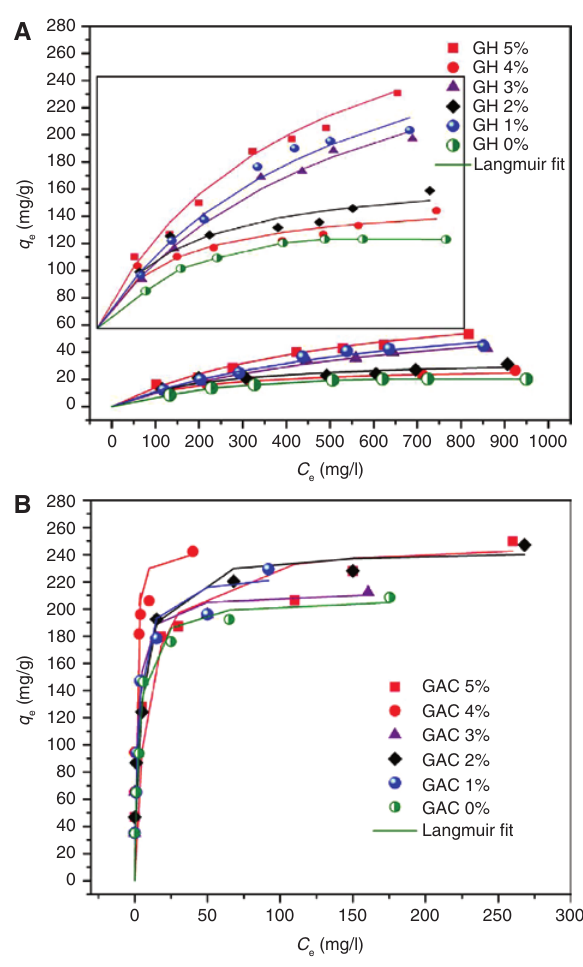
Figure 6: Adsorption isotherms of Cu 2 + ions by various (A) glucose hydrochar and (B) activated carbon (AC)